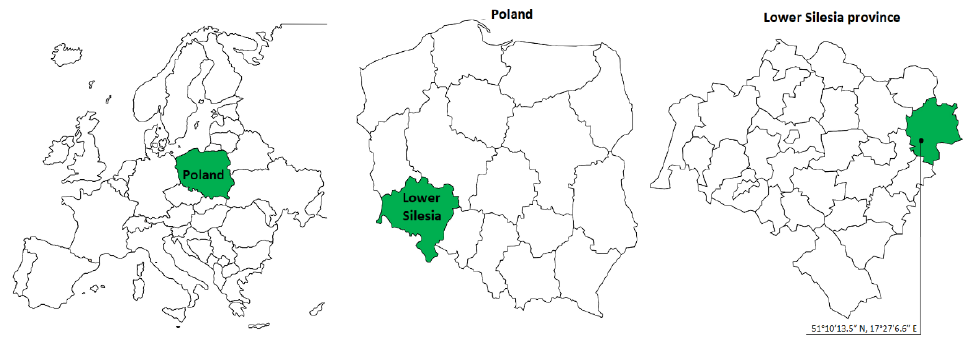
Figure 1. The location of the study area ( • ) on a map of Europe, Poland, and Lower Silesia prov-